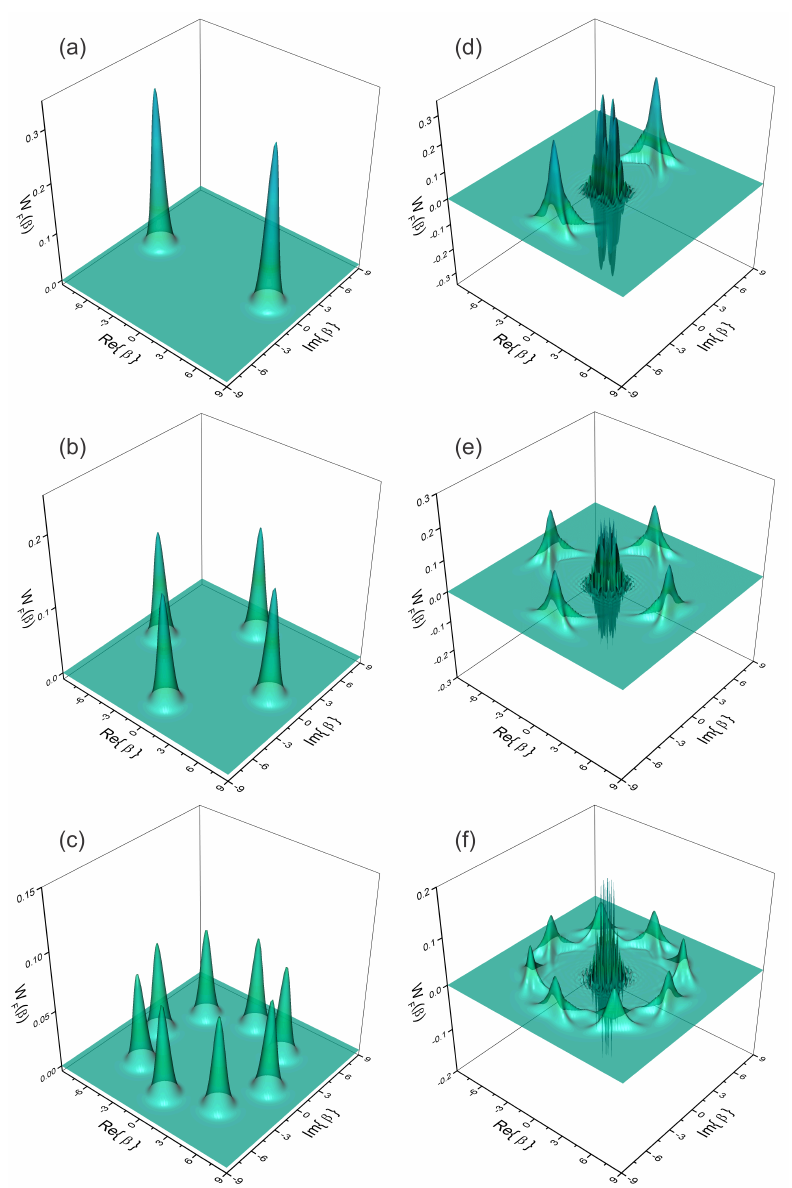
Figure 2. Wigner function for Kaleidoscope-State with α = 6.0 for several values of the time λ t and n . For λ t = 0: ( a ) n = 2, ( b ) n = 4 and ( c ) n = 8; for λ t ≈ 19.15: ( d ) n = 2, ( e ) n = 4 and ( f ) n =